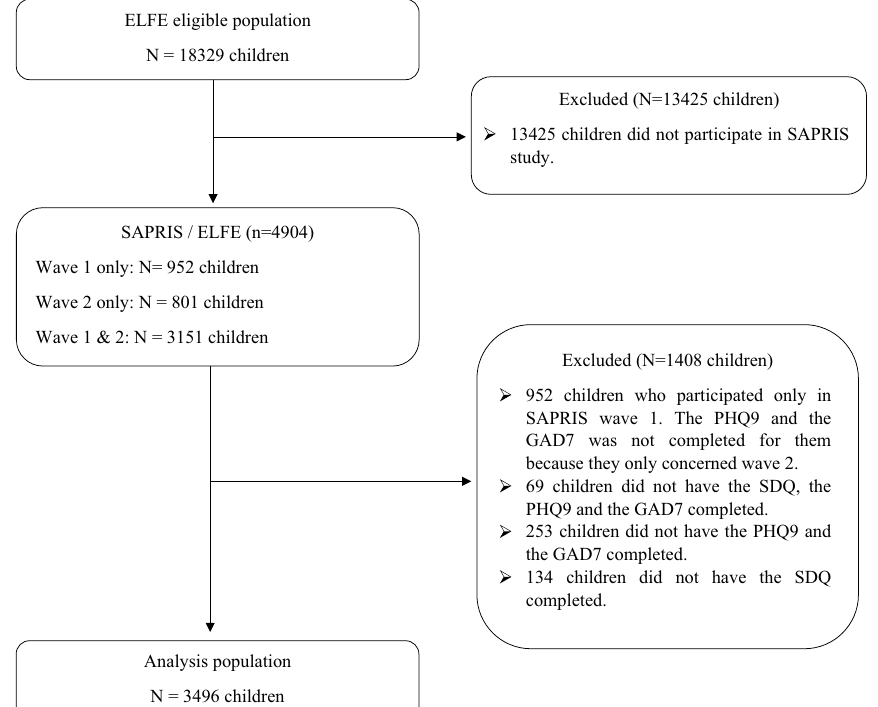
Figure 1. Flowchart of ELFE/SAPRIS cohort during school